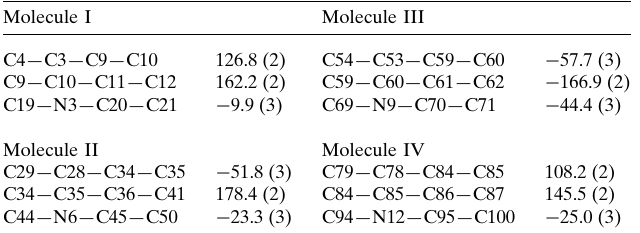
II, III and IV are highlighted in the overlay diagram shown in Fig. 3. The maximum r.m.s. deviation of the overlay between